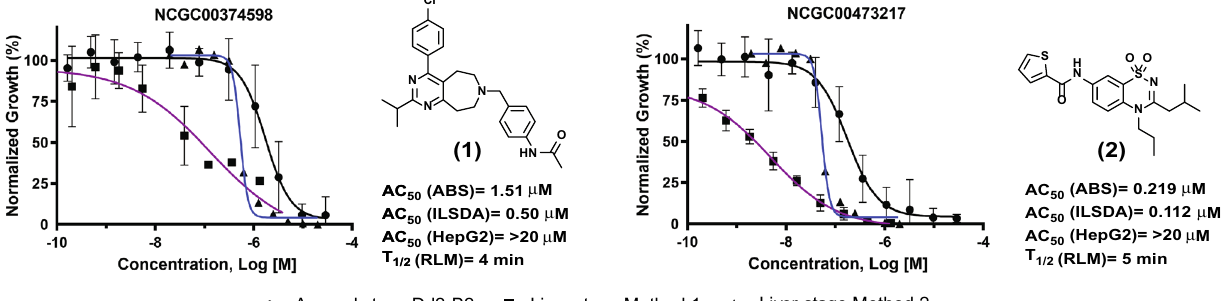
Figure 3. Antiplasmodial activity, toxicity and stability profiles of the prioritized hits NCGC00374598 and NCGC00473217. Compound activity profiles for NCGC00374598 (compound 1 ) and NCGC00473217 (compound 2 ) against P. falciparum asexual blood stage parasites (black line, circle), as well as P. berghei liver stages in either laboratory A (blue line, squares) or laboratory B (purple line, triangles). Percent inhibition is shown on the Y-axis and compound concentration (Log [M]) is shown on the X-axis. Also shown are activities against P. falciparum Dd2 ABS parasites, in vitro inhibition activity in the P. berghei liver stage